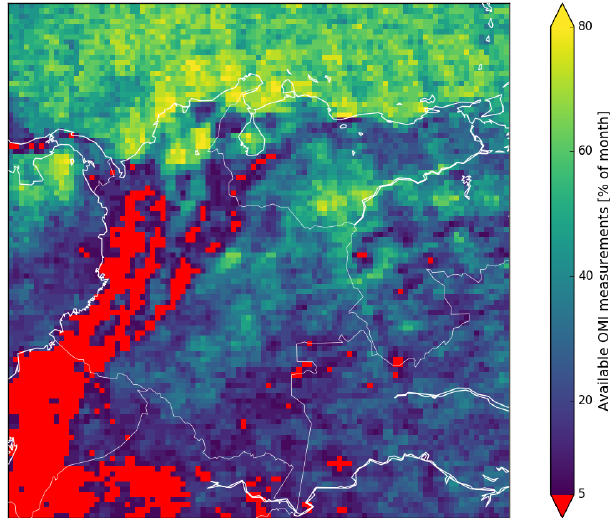
Figure 2. Spatial distribution of the available OMI measurements in January 2014 after filtering was